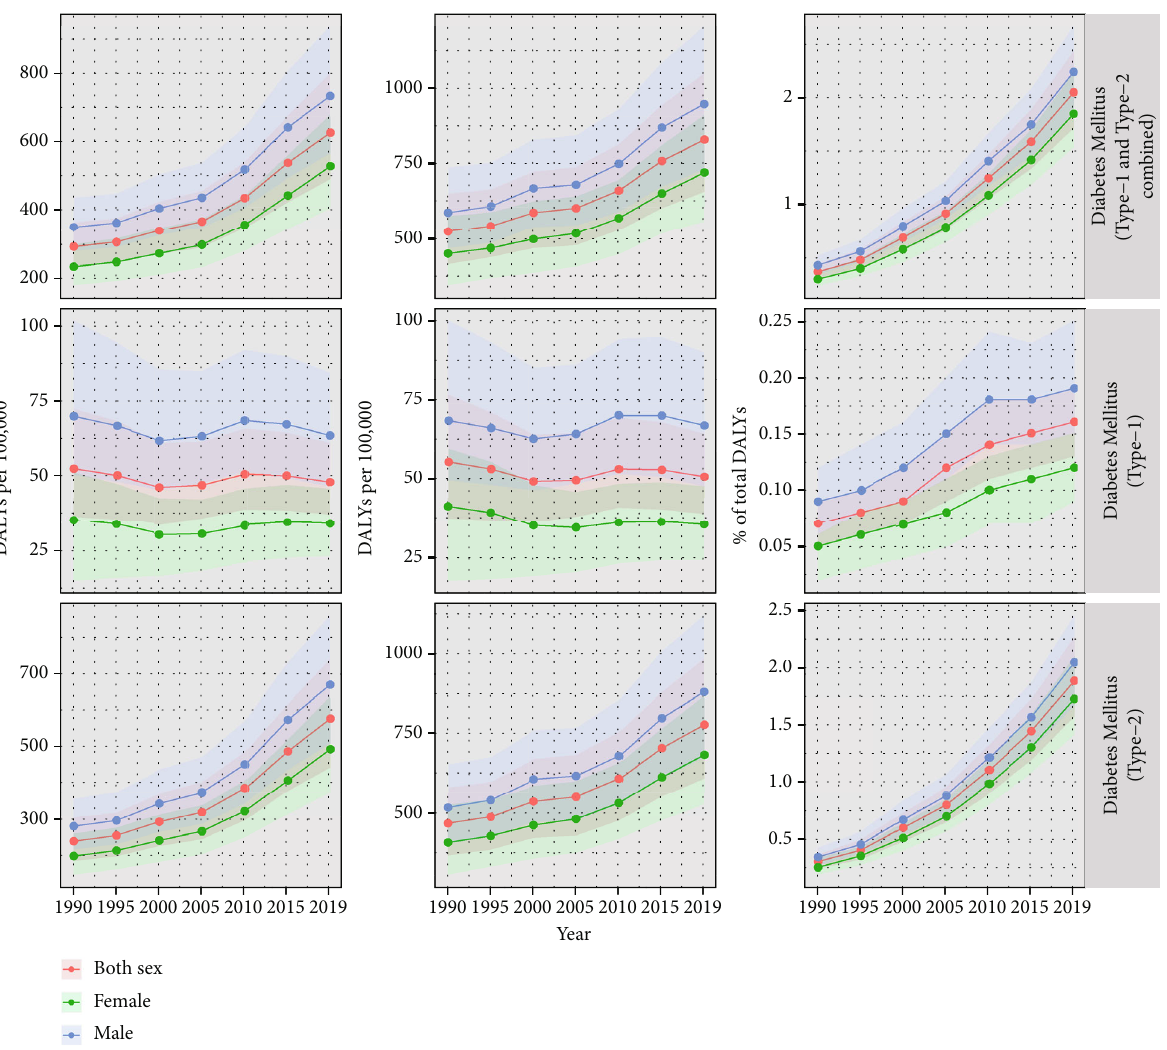
Figure 1: DALYs per 100,000 attributable to